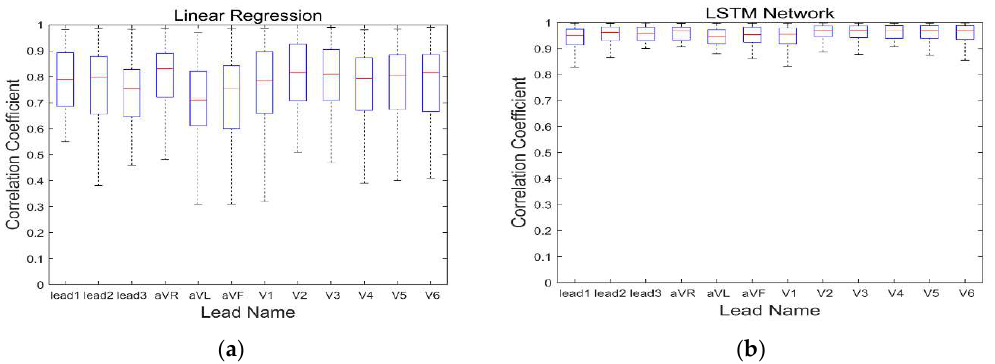
Figure 7. Correlation coefficients between standard 12-lead ECGs and synthesized ECGs. ( a ) Linear regression. ( b ) LSTM network. LSTM: long short-term Table 1. Mean correlation coefficients and RMSE between standard 12-lead and synthesized ECGs.